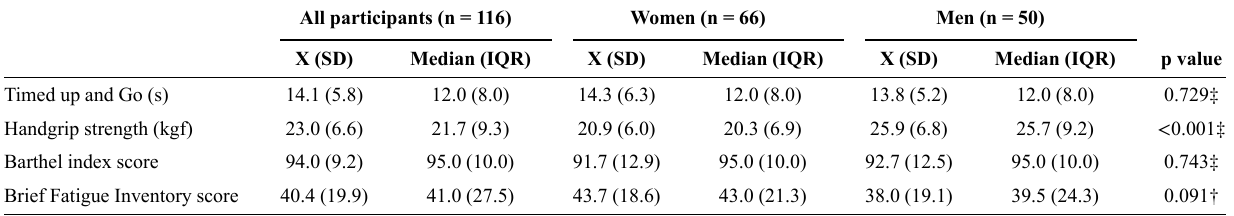
Table 4 - Comparison of TUG, handgrip strength, functional status, and fatigue between older men and older women with cancer (n = 116).